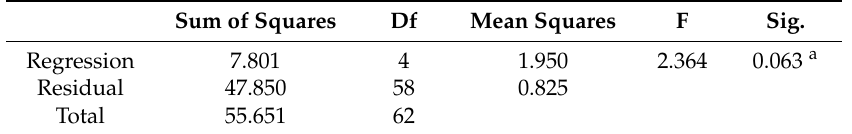
Table 7. The regression analysis of the factors on the aesthetic value evaluation by students Sum of Squares Df Mean Squares F Sig. Regression 7.801 4 1.950 2.364 0.063 a Residual 47.850 58 0.825